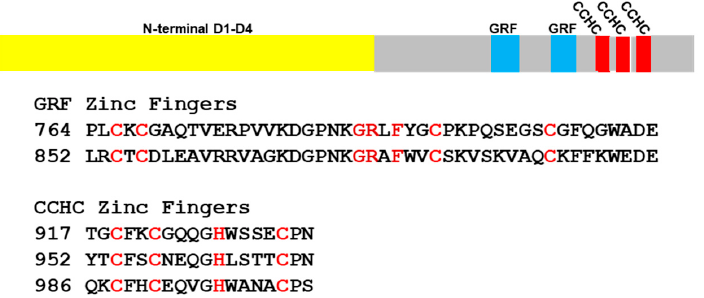
Figure 3. Position and alignment of zinc finger sequences found in topoisomerase III of Puccinia graminis f. sp. tritici . The cysteines and histidines for coordination of Zn 2+ are colored in red. The conserved Gly, Arg, and Phe residues in the zf- GRF zinc fingers are colored in dark red.